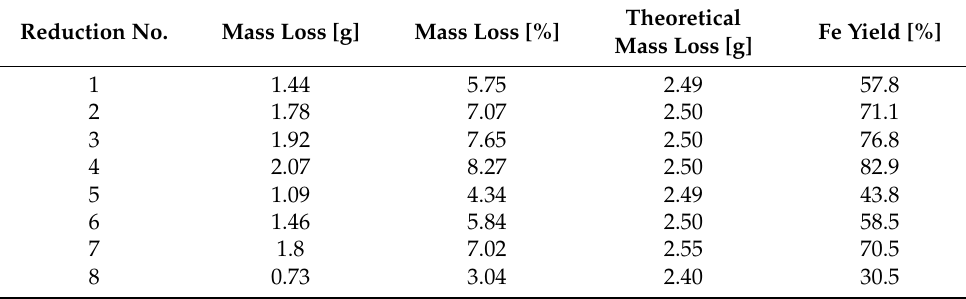
Table 5. Mass loss, theoretical mass loss and Fe yield after hydrogen reduction of pellets. Reduction